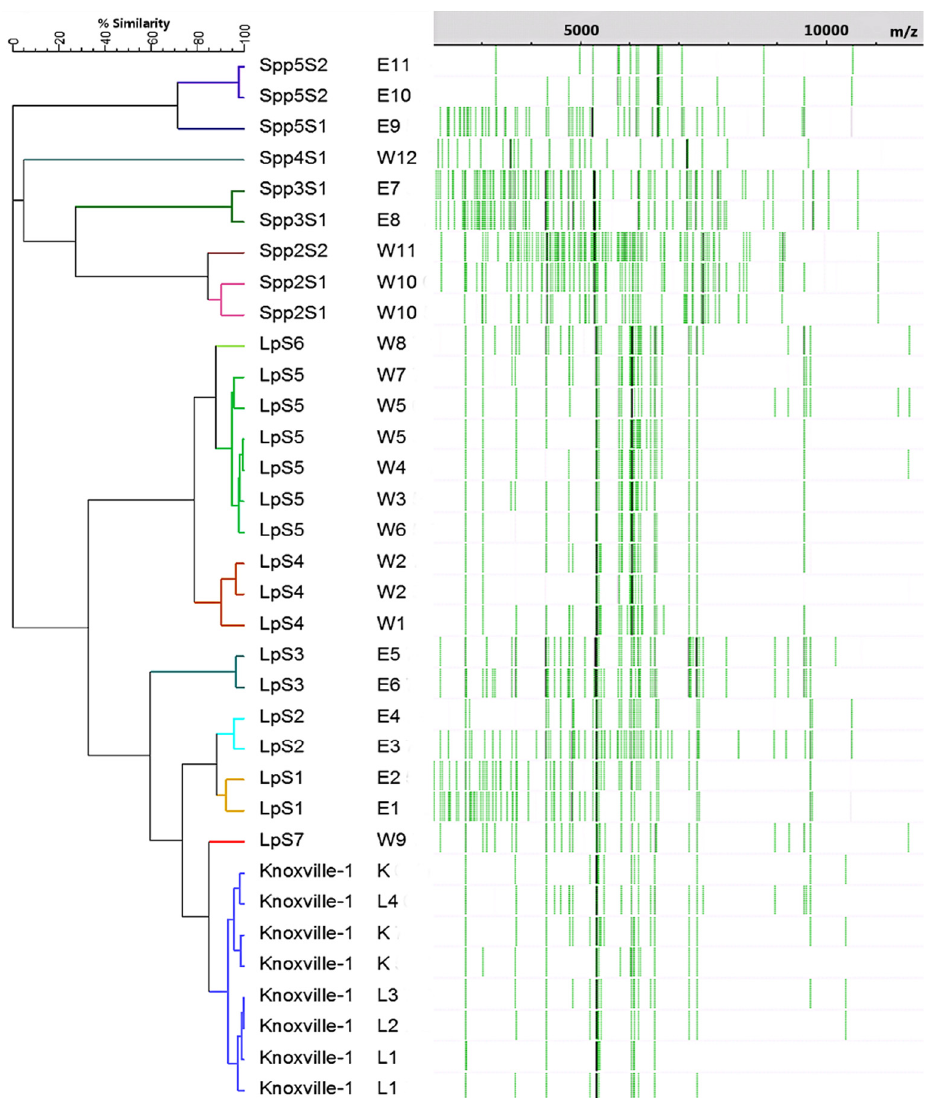
Figure 1. Dendrogram created via cluster analysis of summarized mass spectra from three technical replicates of 34 cultures of 28 Legionella isolates, along with respective mass spectra band data. Similarity coefficients were calculated using peak-based Pearson correlations, and clustering was performed via complete linkage clustering. Cultures K and L1–L4 are isolates of the lab strain Knoxville-1. Samples E1–11 and W1–W12 are environmental isolates from east and west central AZ, respectively. Environmental isolates are labeled as members of L. pneumophila (Lp) or other Legionella species (Spp.) followed by presumptive strain group numbers (e.g., S1) based on the analysis. Terminal branches are color-coded based on presumptive strain groups.